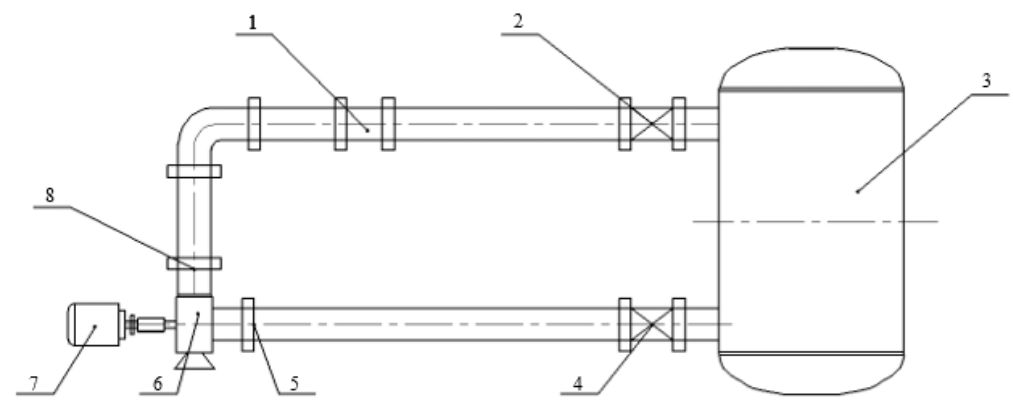
Figure 6. Schematic diagram of test facility. 1. Electromagnetic flowmeter. 2. Outlet pipeline gate valve. 3. Water tank. 4. Inlet pipeline gate valve. 5. Inlet pipeline pressure gauge. 6. Centrifugal pump. 7. Motor. 8. Outlet pipeline pressure gauge.